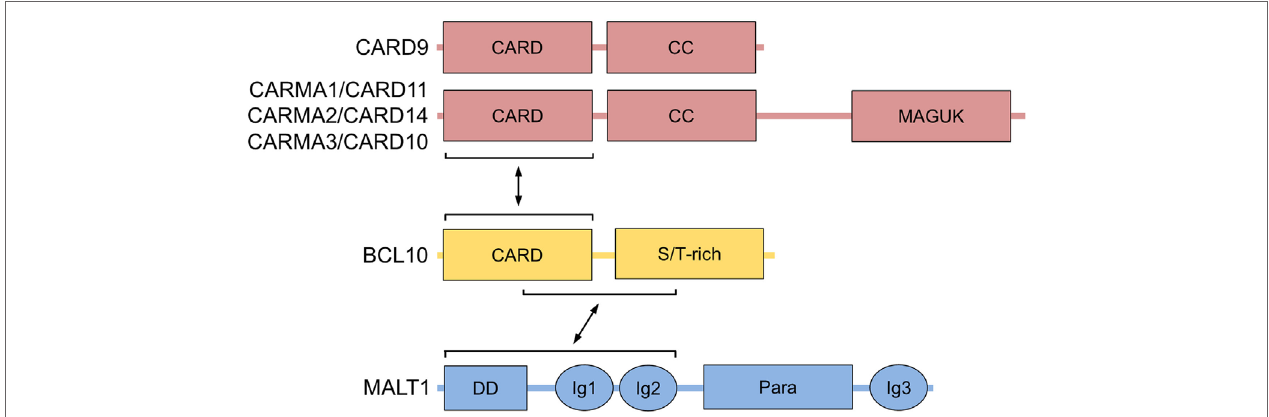
FiguRe 1 | BCL10 structure and interactors. Domain structure of BCL10 with its interacting regions that bind to CARMA/CARDs (CARMA1/CARD11, CARMA2/ CARD14, CARMA3/CARD10, and CARD9) and MALT1 are shown. Abbreviations: CARD, caspase-recruitment domain; CC, coiled-coil; MAGUK, membrane- associated guanylate kinase; S/T-rich, serine/threonine-rich region; DD, death domain; Ig, immunoglobulin-like domain; Para, paracaspase domain; BCL10, B-cell lymphoma/leukemia 10; MALT, mucosa-associated lymphoid